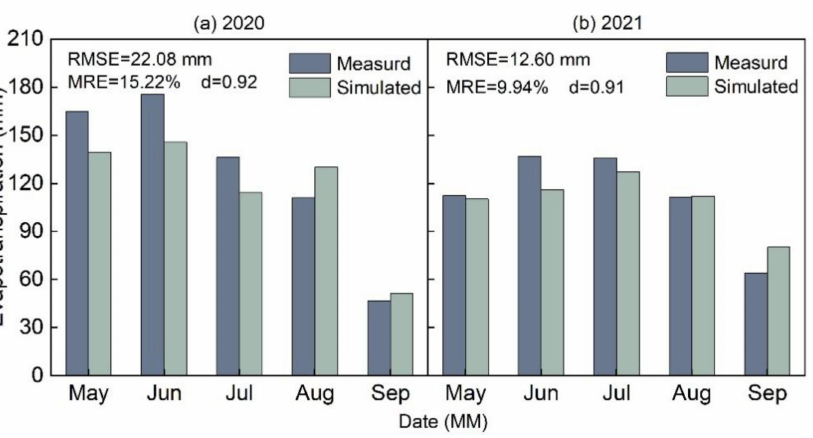
Figure 8. Comparison between measured evapotranspiration (ET) and simulated values by RZWQM2 during the growth period of turf in 2020 and